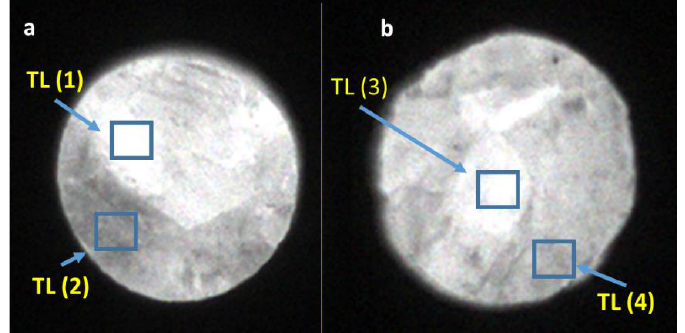
Figure 8. Images of the luminous surface of samples No. 14 ( a ) and No. 21 ( b ) cut out from the LMP crystal doped with 0.8-mol% Tm and 10-mol% B. The images were recorded in a reader with a CCD camera after irradiation with 20 Gy of beta rays. Marked boxes correspond to the sites of TL signal measurement.